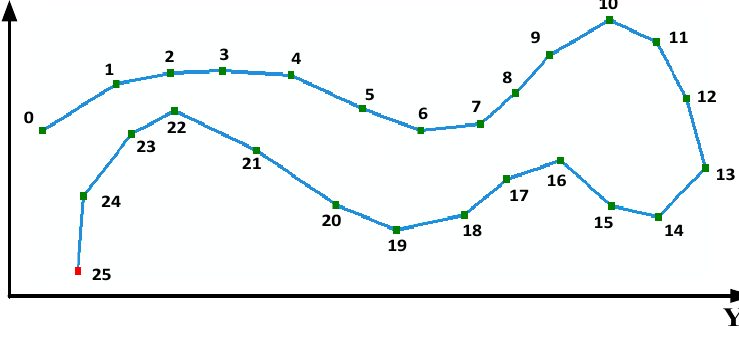
Figure 2. A schematic chart of the monotonic chain.